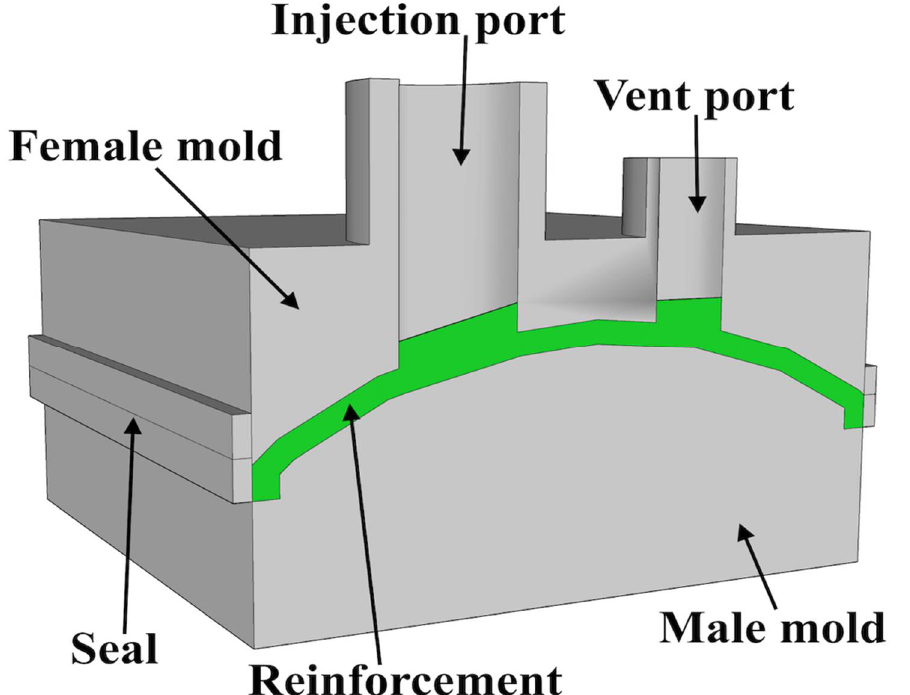
Figure 5. Schematic of resin transfer molding process (redrawn from Ref. [211]).